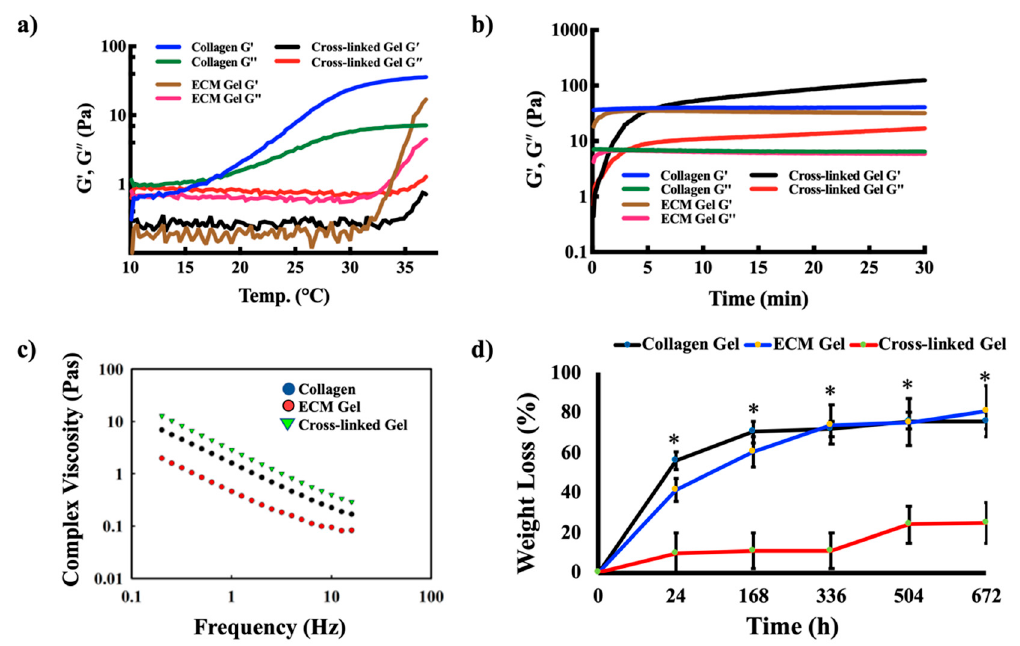
Figure 4. Rheological and degradation analysis of collagen, ADSC ECM, and cross-linked ADSC ECM gels: ( a , b ) gelation kinetics by temperature and time sweep; ( c ) viscosity vs. frequency plots; ( d ) degradation in simulated body fluid (SBF) ( n = 3). The cross-linked gel had significantly lower the degradation rate than the collagen and ECM gels (* p < 0.05).